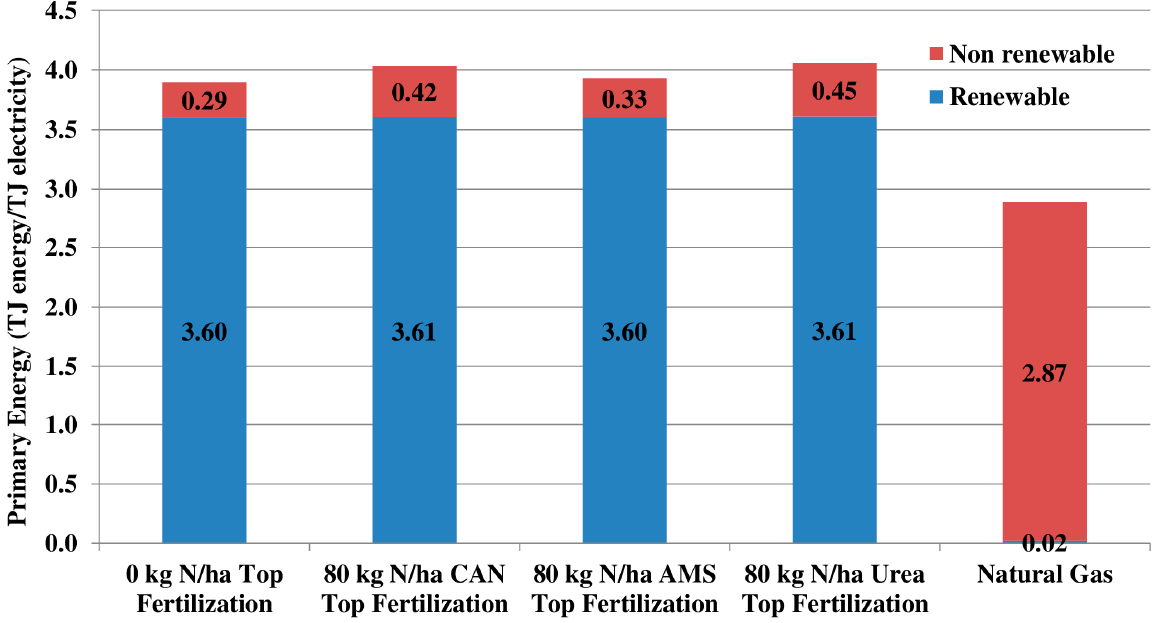
Figure 6. Average total primary energy consumed in the generation of 1 TJe by rye biomass for the four different fertilizer regimes evaluated and by natural gas. CAN: calcium ammonium nitrate, AMS: ammonium sulphate.